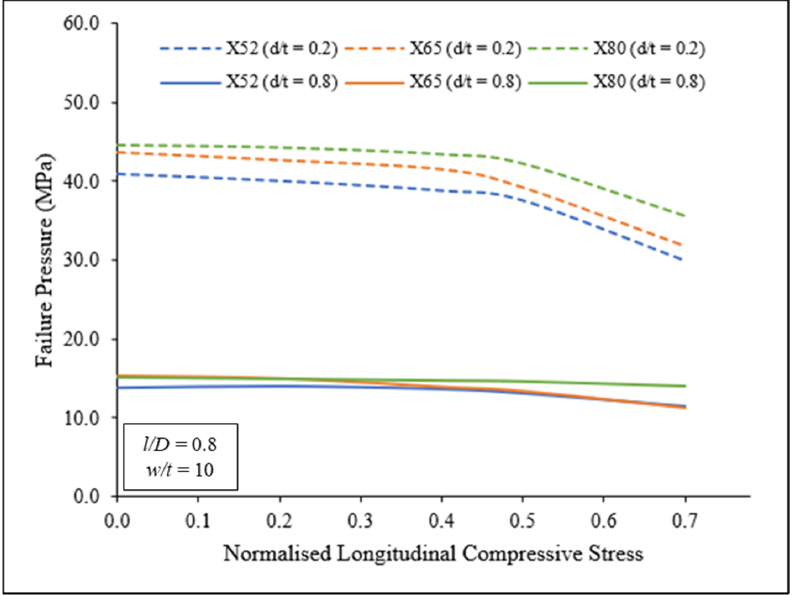
Figure 11. Failure pressure against normalised longitudinal compressive stress with 0.2 and 0.8 normalised defect depths for X52, X65, and X80. 0.8 normalised defect depths for X52, X65, and